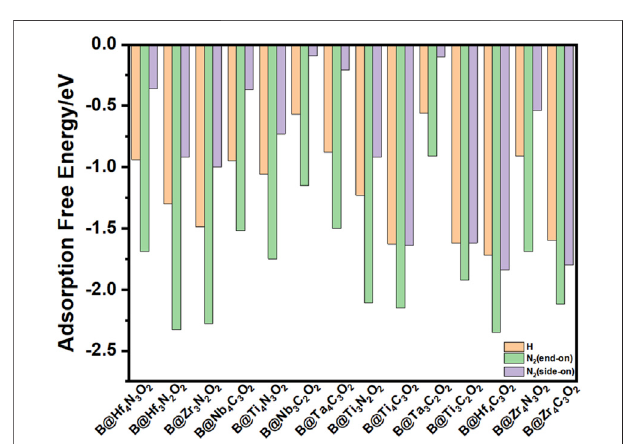
FIGURE 2 | The adsorption energy of proton and N 2 adsorption on fourteen B@MXenes. Both end-on and side-on con fi gurations for N 2 adsorption are